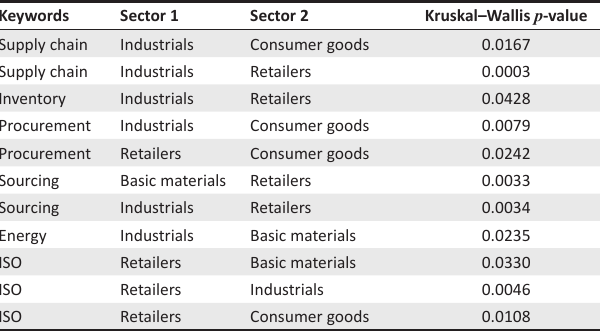
TABLE 6: Significant differences between